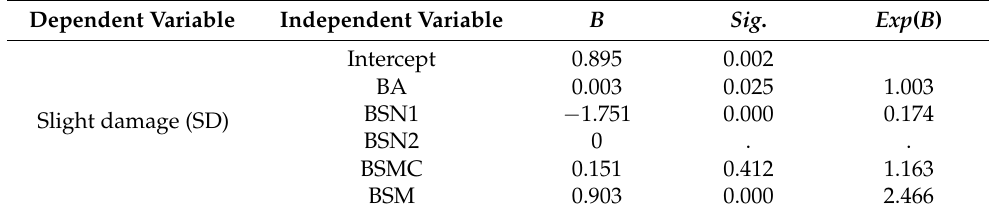
Table 4. Parameter estimates obtained from the multinomial logistic regression